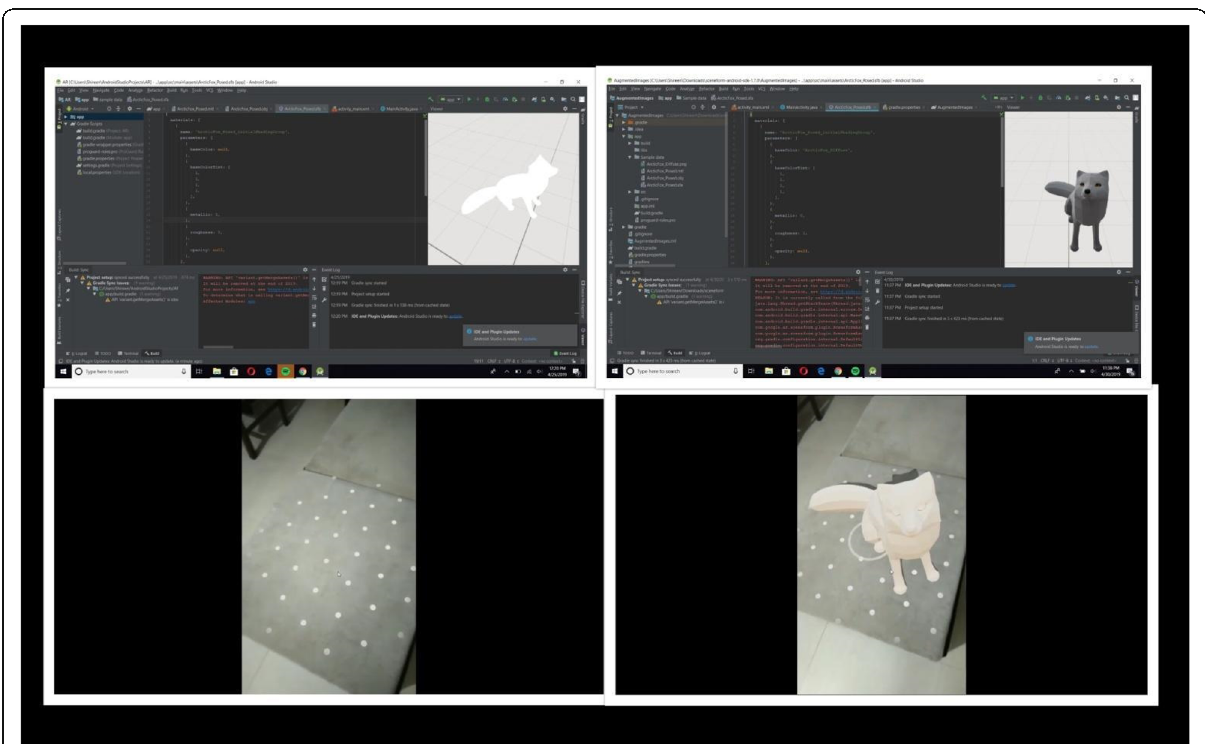
Fig. 4 Implementation of simple application using Android studio, which allows users to project 3D animals into